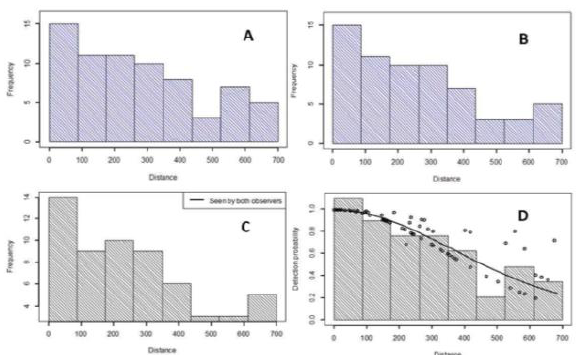
Figure 7. Survey effort in sea states <5 and sightings with group sizes of humpback whales in East and West